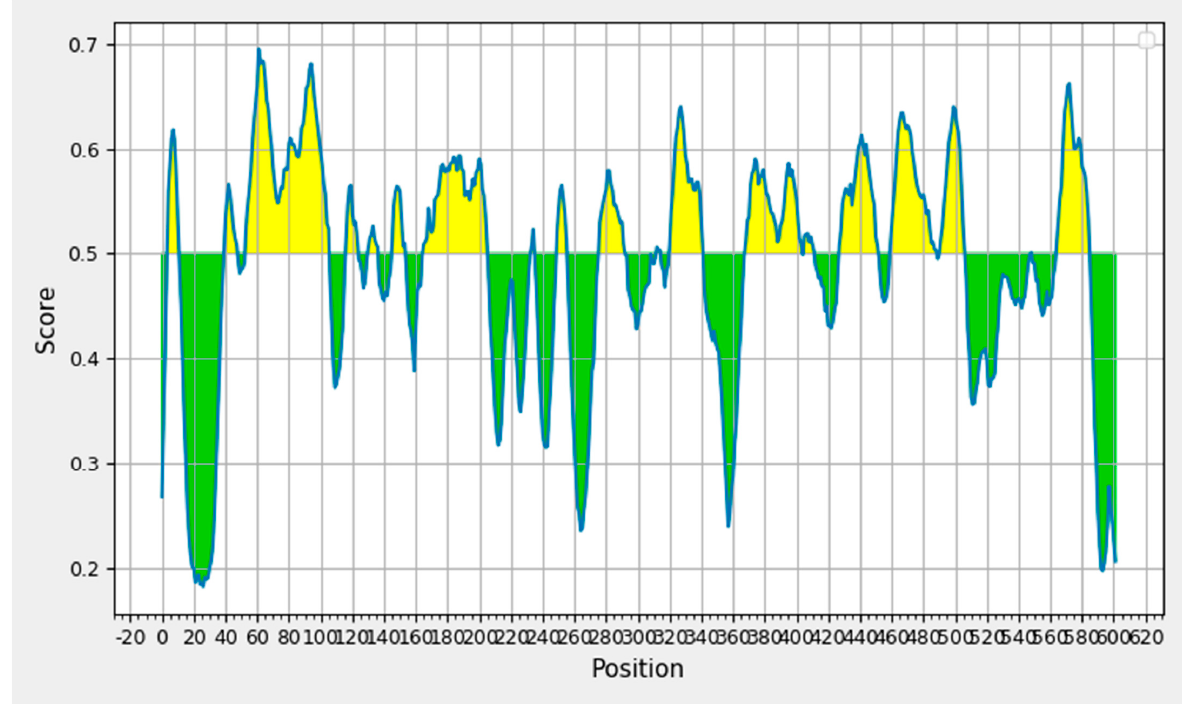
Figure 2. B-cell epitope prediction based on prediction results obtained through Bepipred 2.0.